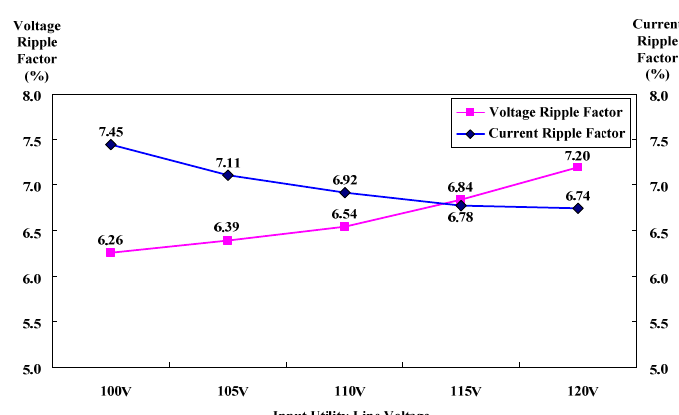
Figure 11. Measured output voltage V o (20 V/div) and current I o (0.2 A/div); time scale: 2 ms/div.